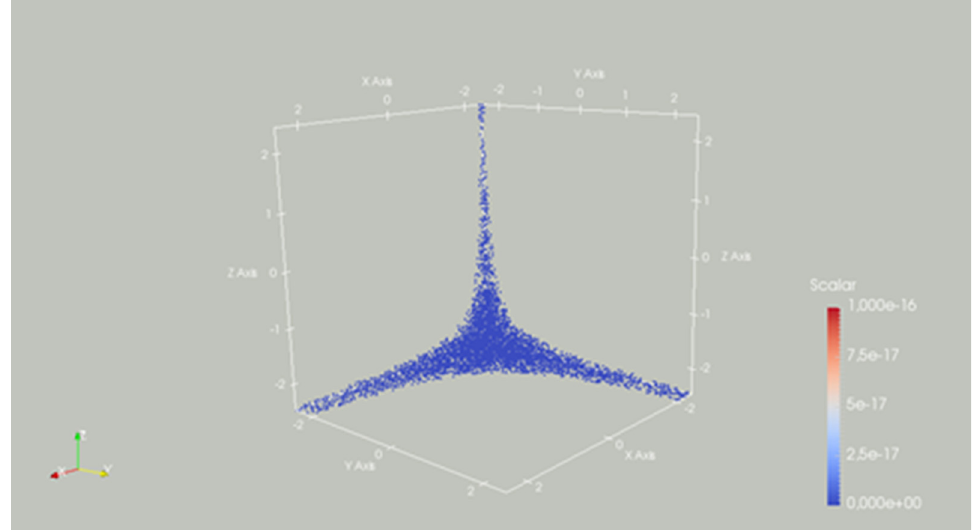
Fig. 3. Representation of the geometry obtained from the intersection of the original cube with 3 hyberbolic cylinders for 5 g of spherical inclusions with a radius of 0.025